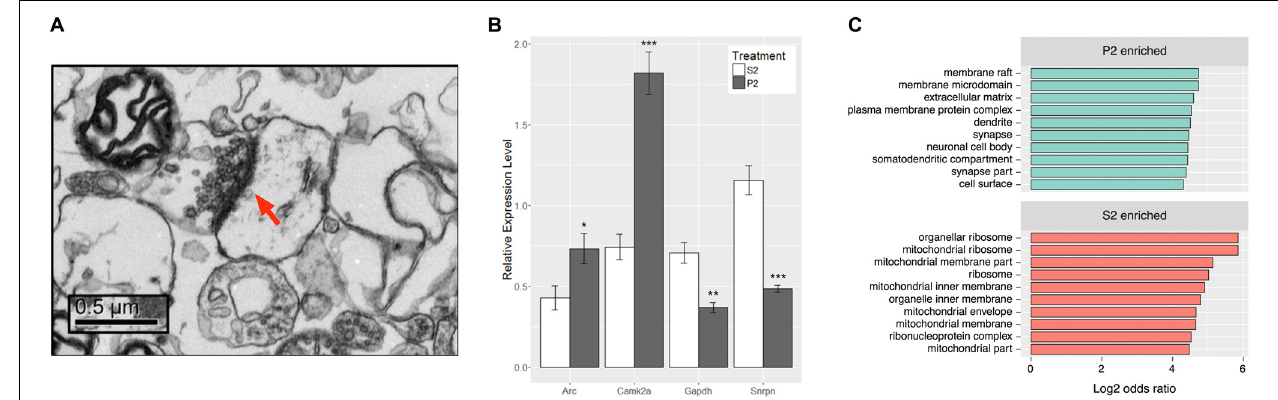
FIGURE 2 | Synaptoneurosome preparation produces distinct RNA populations between P2 and S2 fractions. (A) Representative electron micrograph from P2 fraction observed at 10,000x magnification. Post-synaptic density is labeled by red arrow and presynaptic elements with synaptic vesicles can be observed immediately adjacent. (B) RNA isolated from S2 and P2 fractions of behaviorally sensitized mice was assayed for transcripts of known subcellular localization to ensure enrichment of synaptic RNAs. Camk2a and A rc are transcripts known to be synaptically targeted, while Gapdh and Snrpn are somatically restricted. Paired Student’s t -test between fraction for each gene, Camk2a ( t [7] = 6.941, ∗∗∗ p = 0.0002), Arc ( t [7] = 2.646, ∗ p = 0.0331), Gapdh ( t [7] = 4.181, ∗∗ p = 0.0041), Snrpn ( t [7] = 8.439, ∗∗∗∗ p < 0.0001), n = 8. (C) Top 10 Gene Ontology Cellular Compartment categories according to p -value as derived from functional enrichment analysis of the untreated P2 enriched gene list (SSP vs. SSS), sorted by log 2 of the categories’ odds